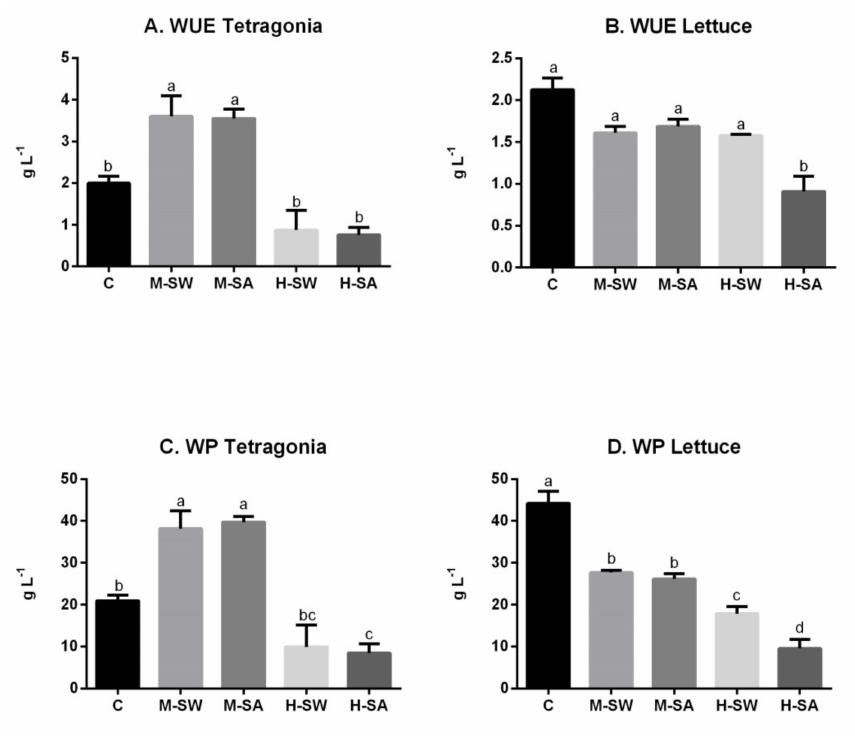
Figure 3. Plants WUE ( A , B ) and WP ( C , D ). Values are means ( n = 4) ± SEM expressed in grams per liter. Different letters indicate significant differences assessed at p < 0.05 (Tukey’s